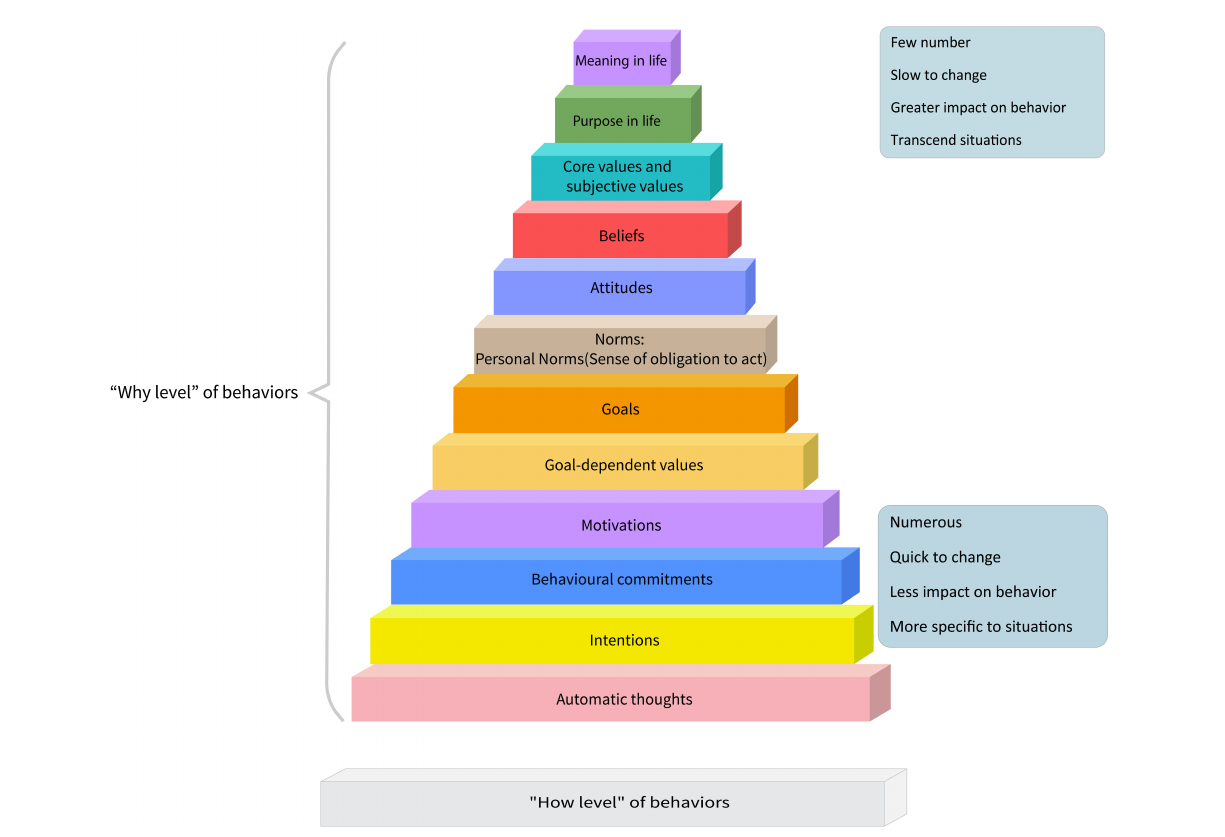
FIGURE3 “Why level” cognitive hierarchy. Summarizing previous studies on the causal hierarchy of cognitive constructs that leads to human behaviors, the above model is proposed. Psychological constructs that lead to one’s goal-directed behaviors (including marital behaviors) are organized within a hierarchy of abstractions that are causally related, wherein moving to higher levels is accompanied by a decrease in the number of constructs and an increase in their abstraction and impact on behaviors. Based on different theoretical approaches, some minor displacements in this hierarchy is not